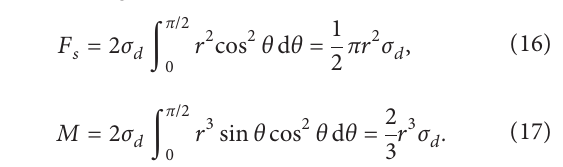
Figure 10: Modified epoxy resin